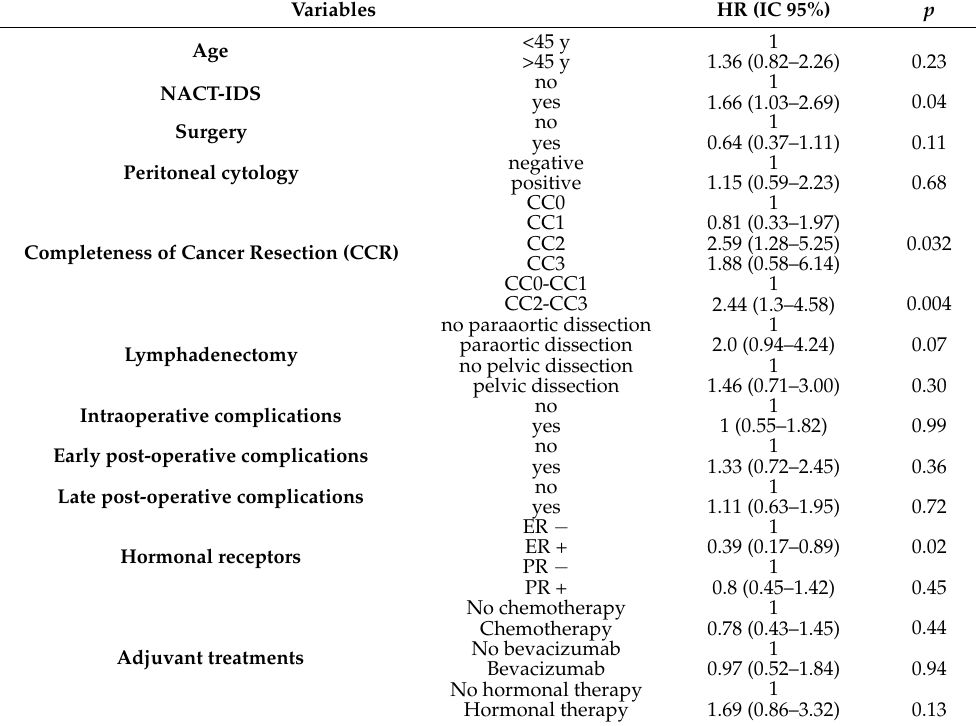
Table 5. Progression-free survival